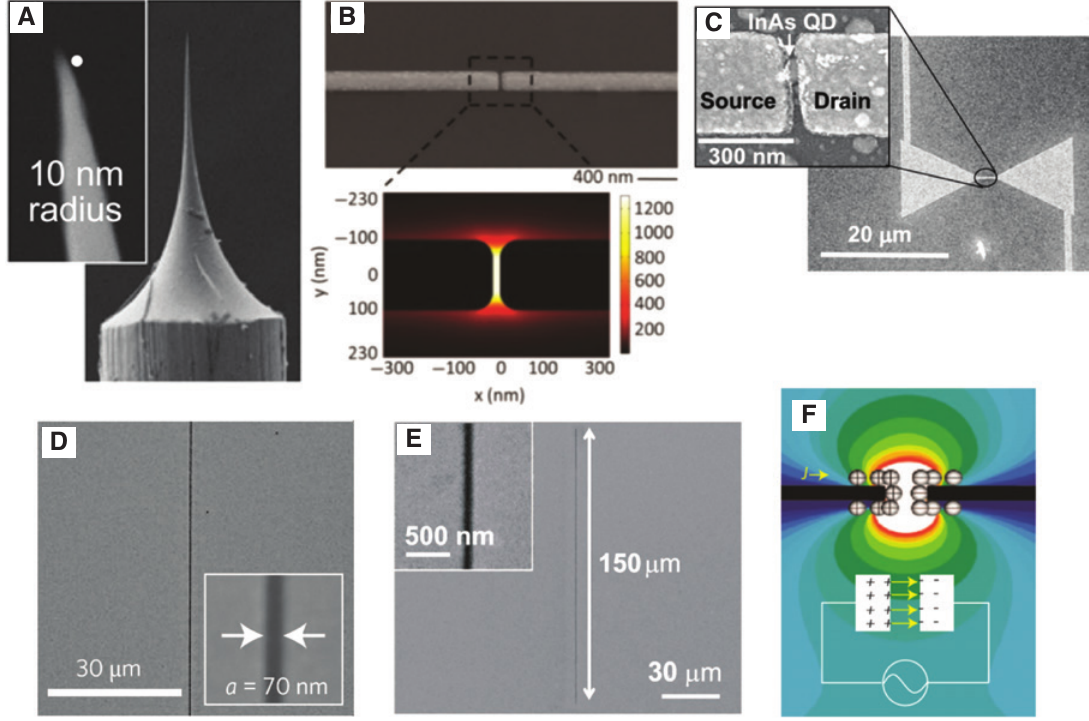
Figure 1: Metal nanostructures for strong field enhancement and confinement of terahertz waves. (A–E) SEM images of metal nanotip (A), dipole antenna (B), bowtie-shaped nanoantenna (C), nanoslit (D), and nanoslot antenna (E), respectively. (F) Enhanced electric field distribution induced by charge accumulation and capacitive coupling in metal nanogap. The figures are reproduced from References [26,